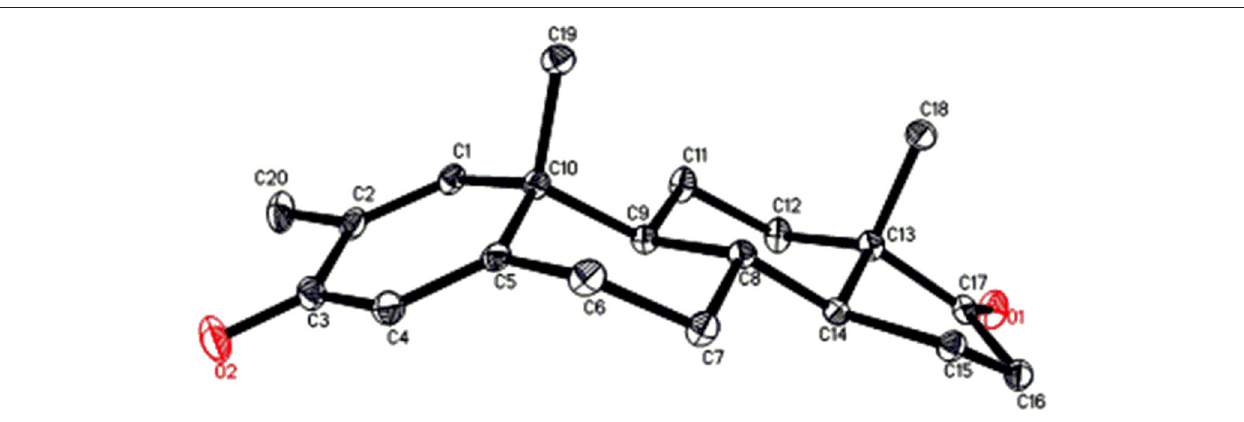
FIGURE 7 | Computer-generated ORTEP drawing of final X-ray model of compound 5 . Color codes: carbon, black; oxygen,